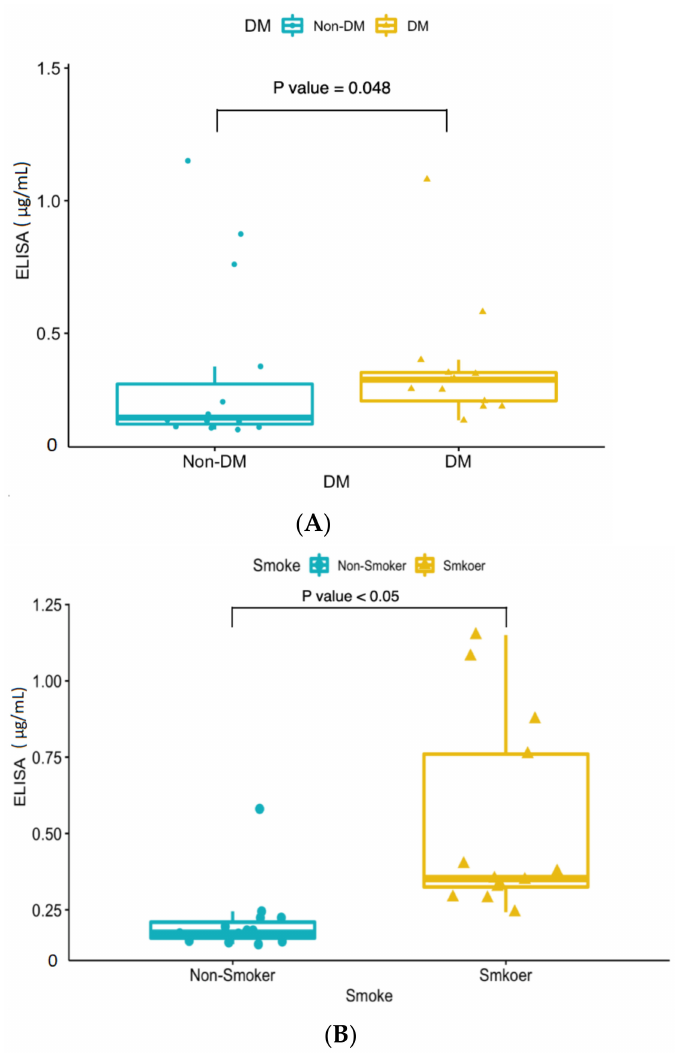
Figure 6. ( A ) ELISA analysis of significant concentration ( µ g/mL) changes in the alpha-2-HS- glycoprotein between the diabetes mellitus (DM) groups and cataract control group. ( B ) ELISA analysis of significant concentration ( µ g/mL) changes in the alpha-2-HS-glycoprotein between the smoking groups and cataract control group. DM group ( n = 13): DM single-risk patients ( n = 5) + double-risk patients ( n = 8); Non-DM group ( n = 14): smoking single-risk patients ( n = 5) + cataract control group ( n = 9); Smokers ( n = 13): smoking single-risk patients ( n = 5) + double-risk patients ( n = 8); Non-smokers ( n = 14): DM single-risk patients ( n = 5) + cataract control group ( n =